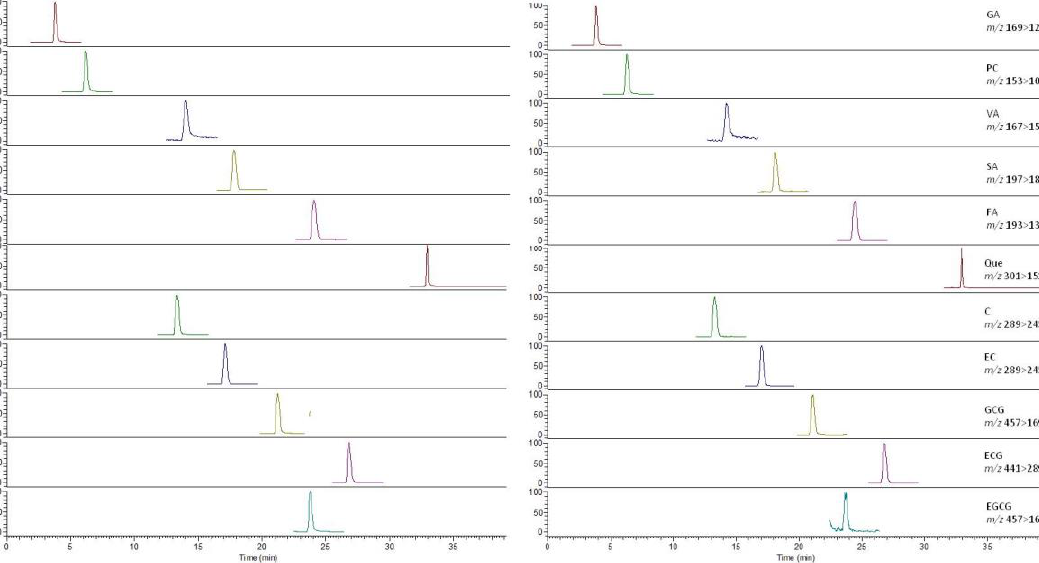
Figure 1 ． UPLC-MS total ion count chromatograms of 11 non-anthocyanin polyphenols (( Left ), standard; ( Right ), commercial blueberry sample).